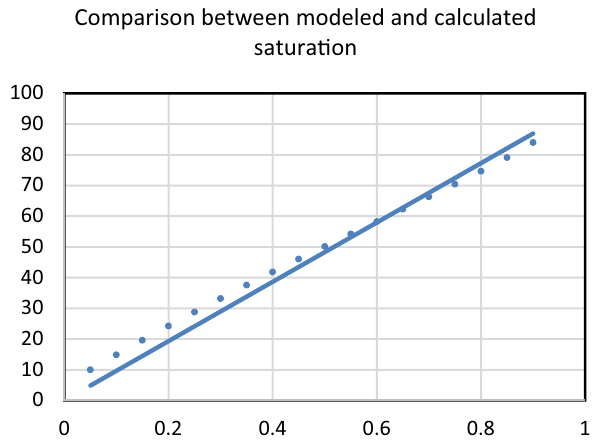
Fig. 32 Hydrocarbon saturation from density